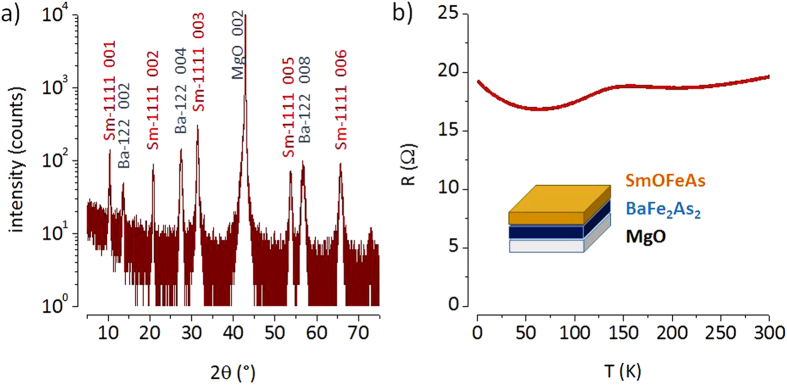
(a) High resolution XRD (2θ/ω-scan) of SmOFeAs/BaFe2As2/MgO. 00l reflections of each phase are indexed. The BaFe2As2 layer (Ba-122) has a thickness of about 16 nm (c122 = 12.97 Å). The SmOFeAs layer (Sm-1111) was deposited at 860 °C and is about 36 nm thin (c1111 = 8.53 Å). (b) No superconducting transition is detected in the electrical resistance measured down to 2 K.